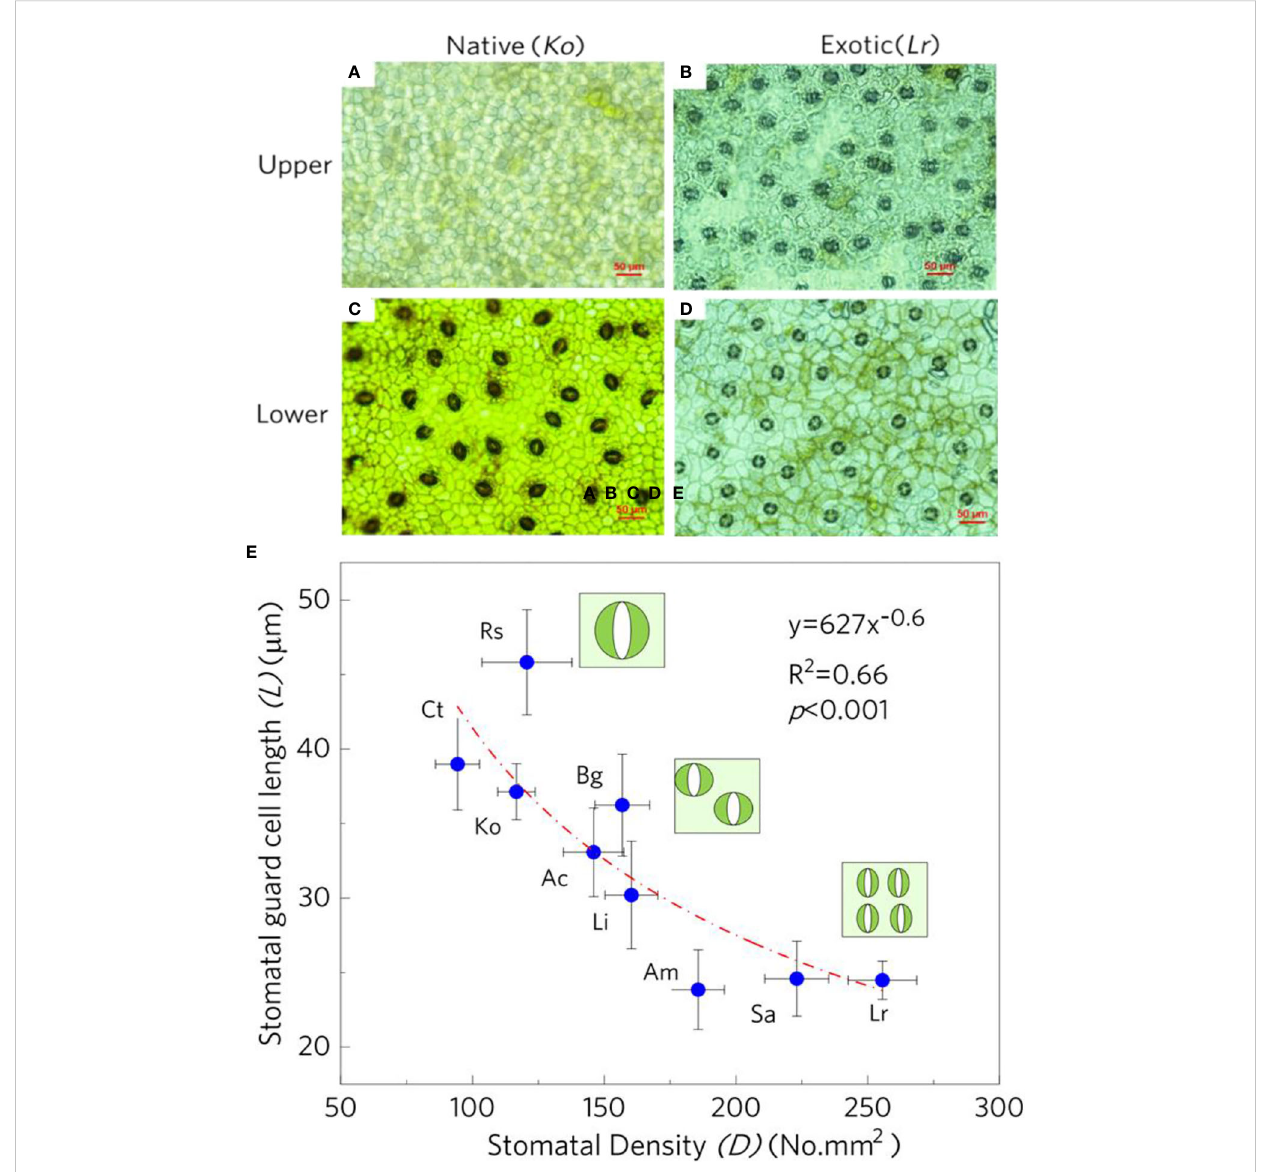
FIGURE 1 Comparisons in leaf stoma distribution and density between a native mangrove K. obovate and an exotic mangrove L. racemosa , the upper epidermis of K. obovate (A) and L. racemosa (B) , the lower epidermis of K. obovate (C) and L. racemosa (D) , the relationship between stomatal density and stomatal length pooled for different mangrove species (E) .The error bars represent Mean±SE (n=5), and the species name abbreviations are as follows: Rs, Rhizophora stylosa ; Ct, Ceriops tagal ; Ko, Kandelia obovata ; Bg, Bruguiera gymnorhiza ; Ac, Aegiceras corniculatum ; Ll, Lumnitzera racemosa ; Am, Avicennia marina ; Sa, Sonneratia apetala ; Lr, Laguncularia racemosa